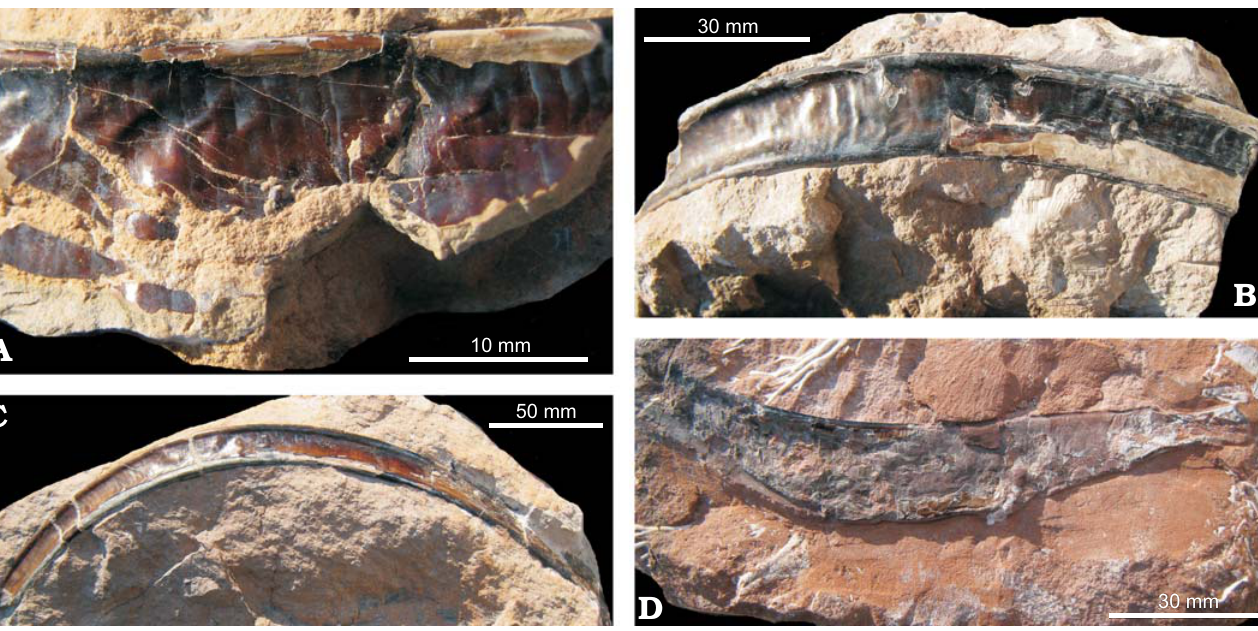
Fig. 2. Tubes of Sphenothallus aff. longissimus ( A–C ) and Sphenothallus kukersianus (Öpik, 1927) ( D ) Viivikonna Formation, lowermost Sandbian, NE Estonia. A . TUG 73-37 from Kohtla-Järve. B . TUG 1087-14 from Kohtla. C . TUG 2-551 from North East Estonia, oil shale basin. D . TUG 1087-12 from